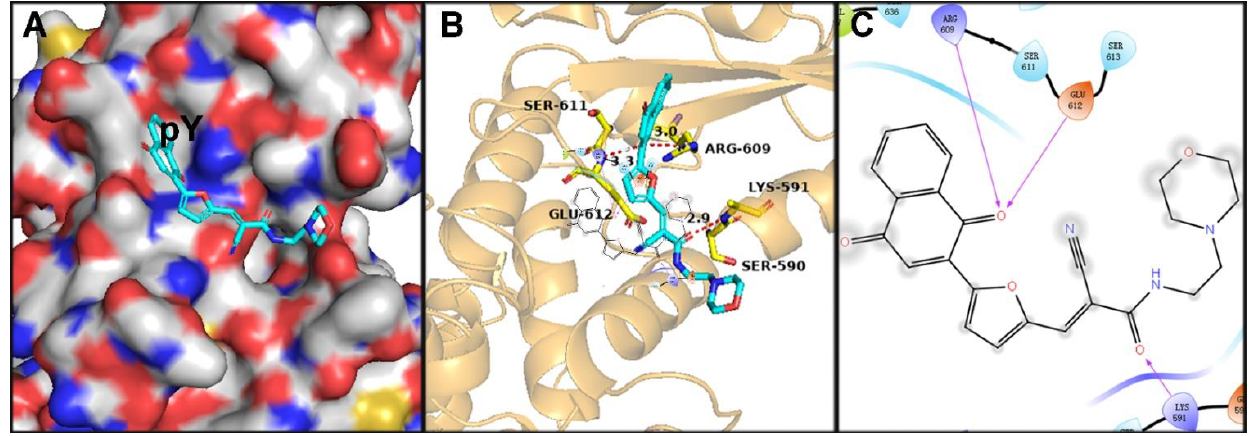
Figure 11. Molecular docking. ( A ) Docked conformation of compound 5c into the active site of STAT3. ( B ) 3D model of 5c bonded with the active site of STAT3. ( C ) 2D model of the interactions between the amino acid residues and compound 5c . The docking model between compound 5c and the SH2 domain of the STAT3 protein (PDB: 6NUQ) was produced by Schrodinger software.